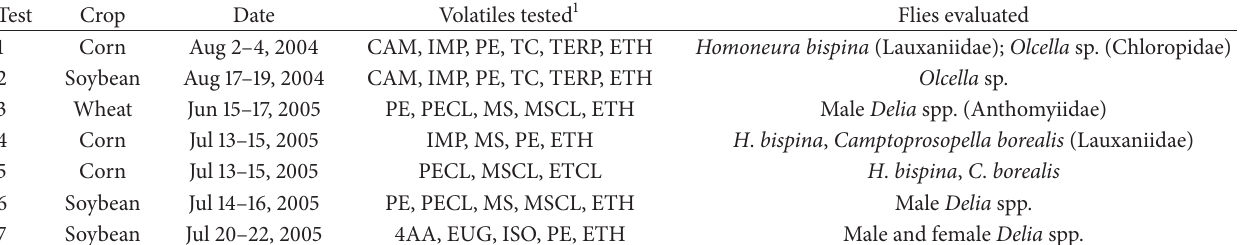
Table 2: Tests of the attractancy of volatile chemicals to beneficial insects in agricultural plots near Brookings, SD.